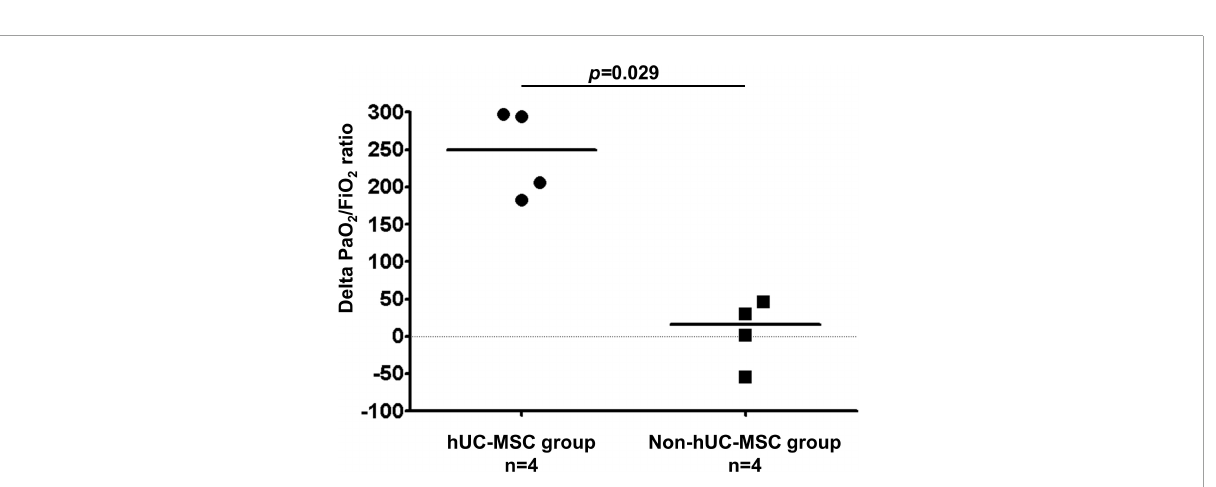
FIGURE4 Delta PaO 2 /FiO 2 ratio difference on hUC-MSC and non-hUC-MSC patients. The delta PaO 2 /FiO 2 ratio which was the difference of PaO 2 /FiO 2 ratio between the admission day and day 7 of hospitalization also showed a larger increment in the hUC-MSC treated patients than in non-hUC-MSC patients (250.06 [188.78–296.90] vs. 15.76 [–40.12–42.32], P = 0.029). Abbreviations as in Figure 2